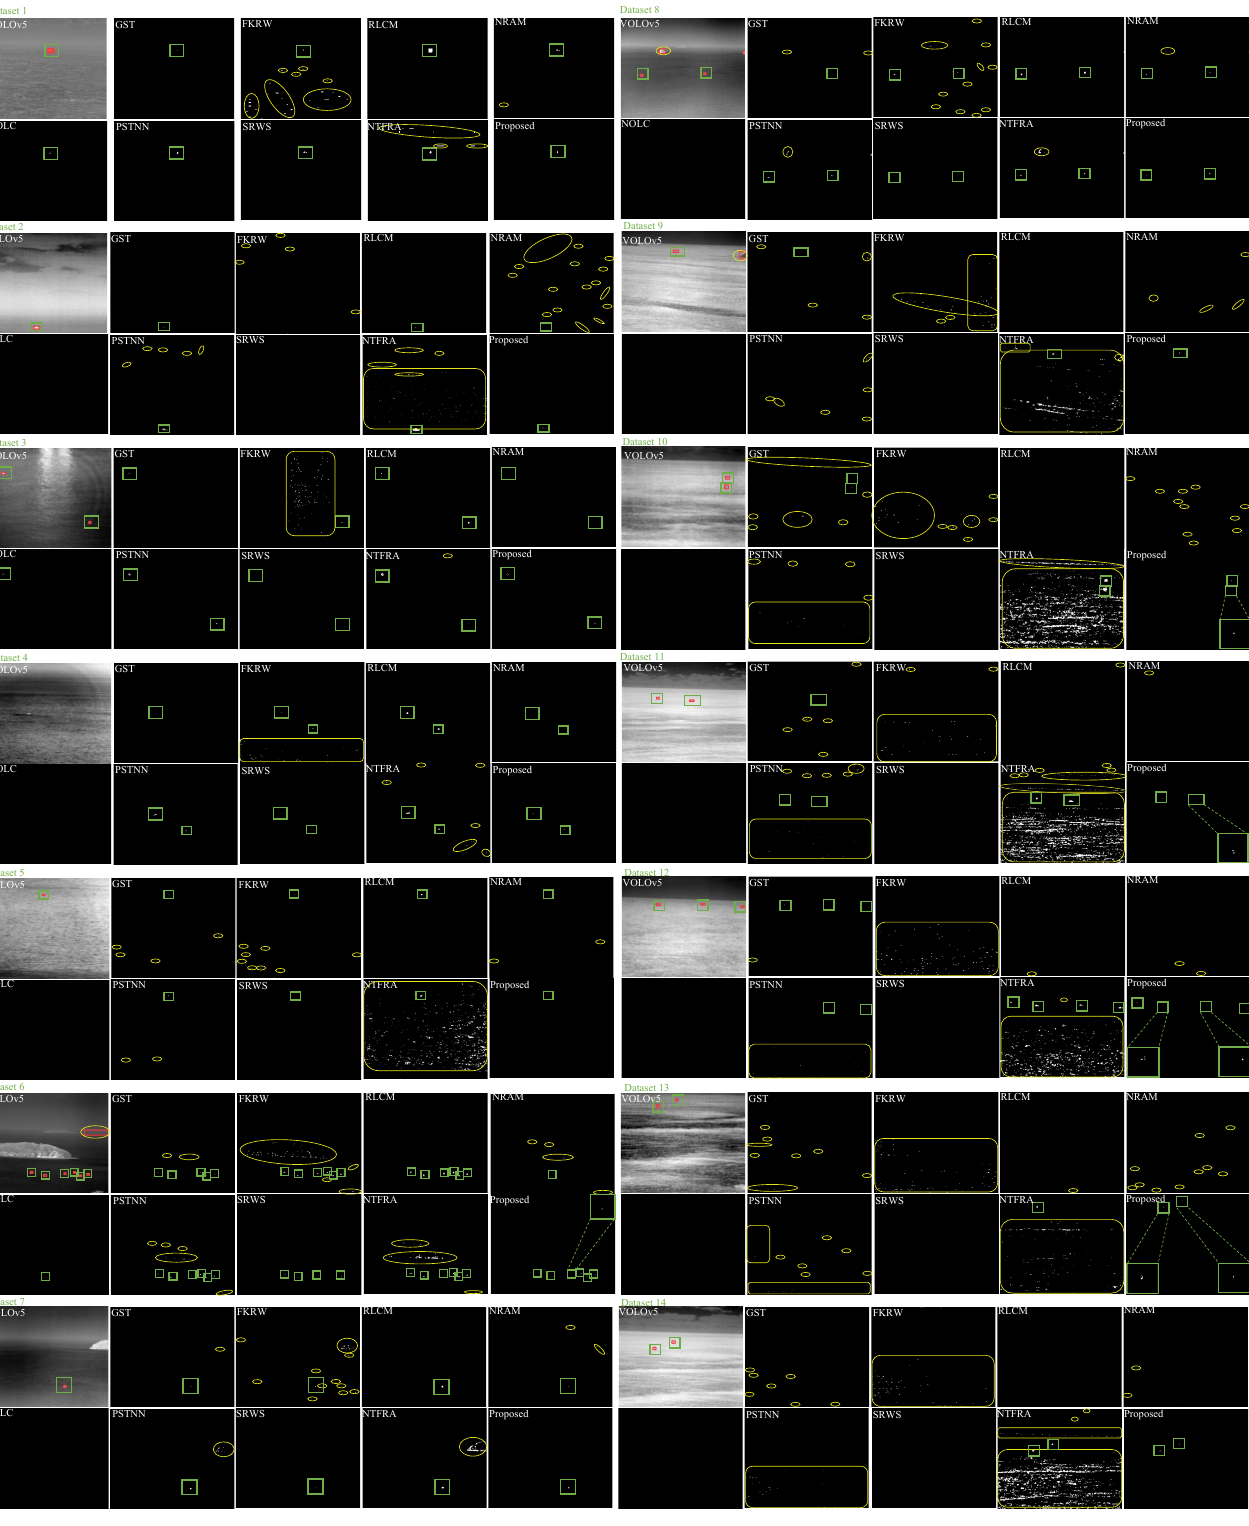
Figure 9. Qualitative comparison of detection results of baseline methods. The red mark indicates the target detected by VOLOv5; The green marks indicate the correct targets detected by different methods; The yellow marks indicate false targets detected by different